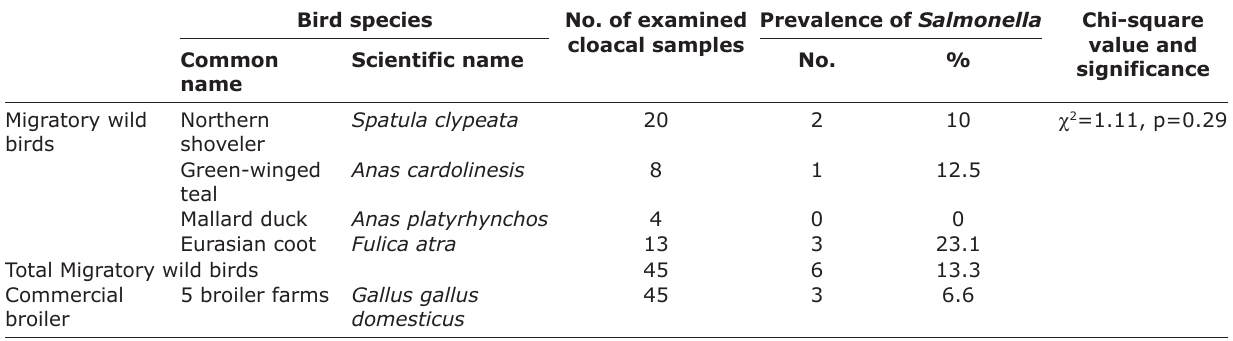
Table-4: Prevalence of Salmonella in the examined cloacal samples collected from wild and domesticated bird species. Bird species No. of examined Prevalence of Salmonella Chi-square cloacal samples value and